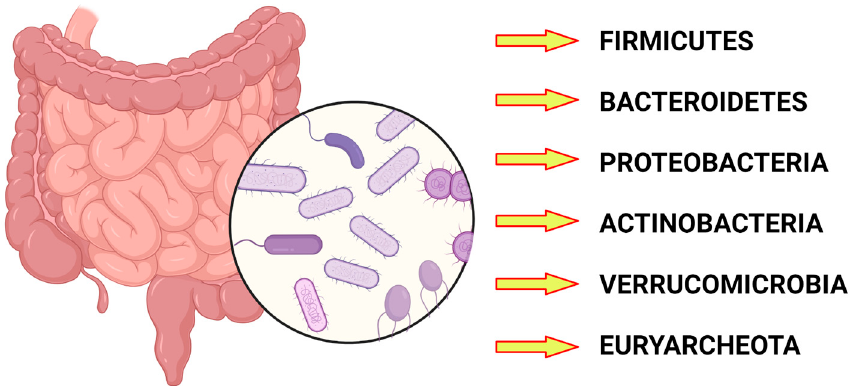
Figure 1. The main phyla constituting the gut microbiota. Created with